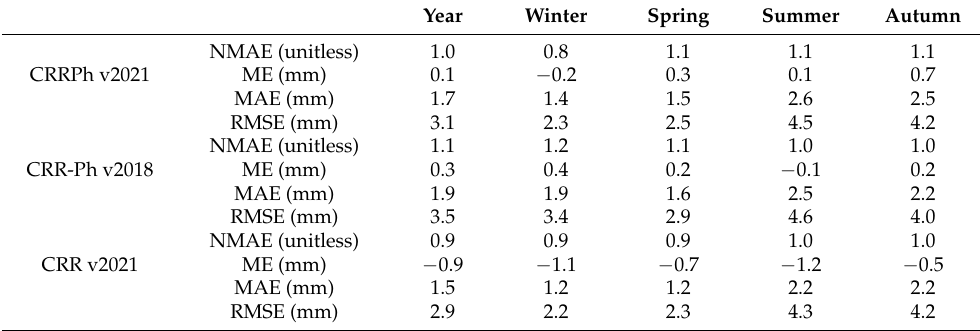
Table 6. Daytime error statistics for CRRPh v2021, CRR-Ph v2018, and CRR v2021.